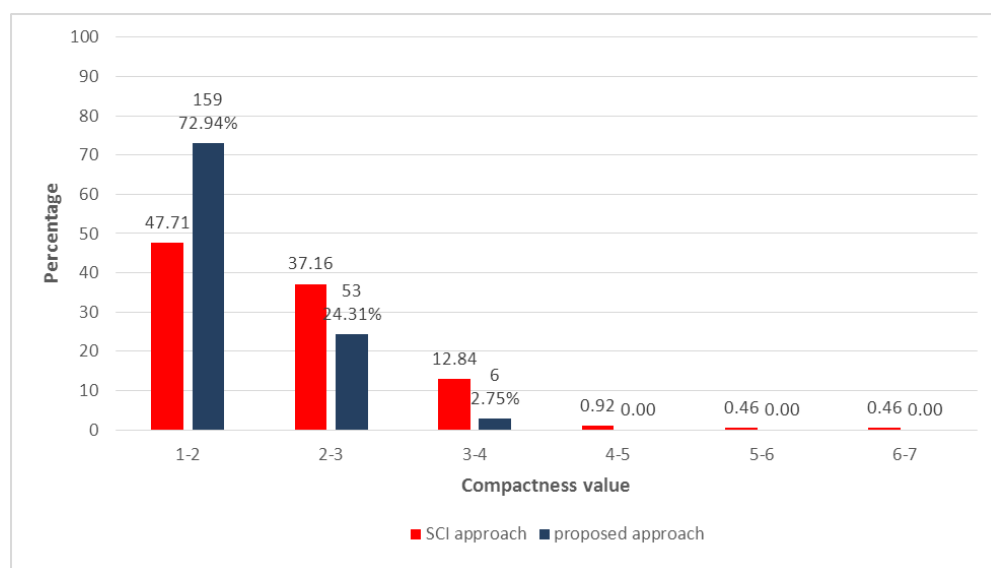
Figure 7. Distribution of the compactness values for the two